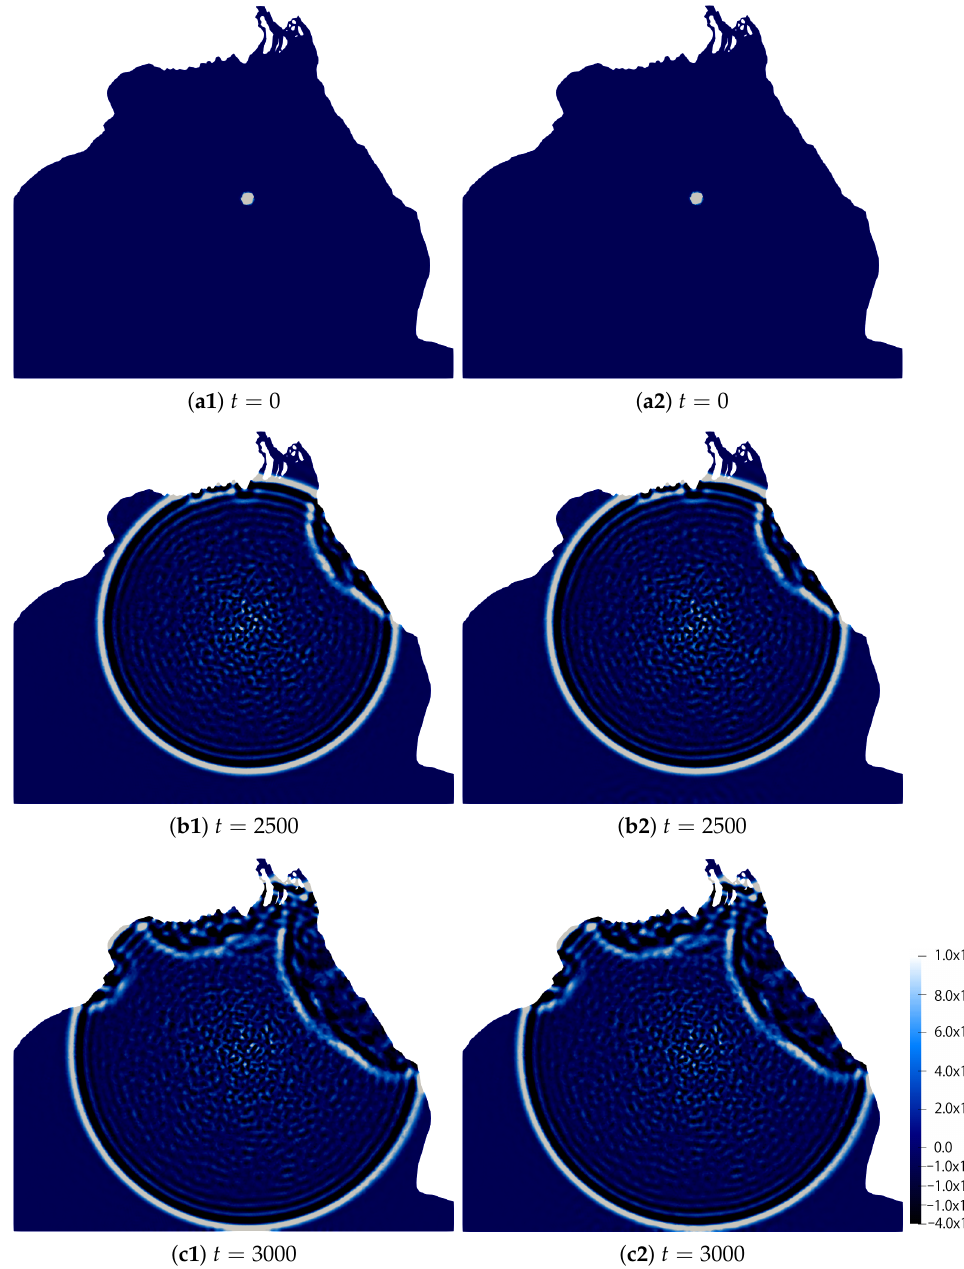
Figure 9. Contour plot of η n by LG2 with Γ = Γ D ( left ) and Γ = Γ D ∪ Γ T ( right ) on the Bay of Bengal h for t = 0,2500 and